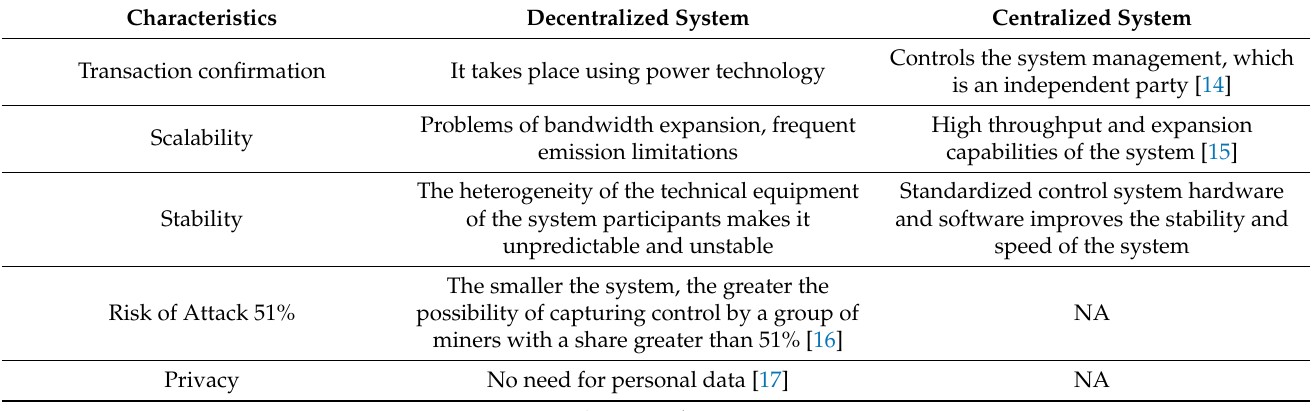
Table 1. Characteristics of centralized and decentralized cryptocurrency systems.